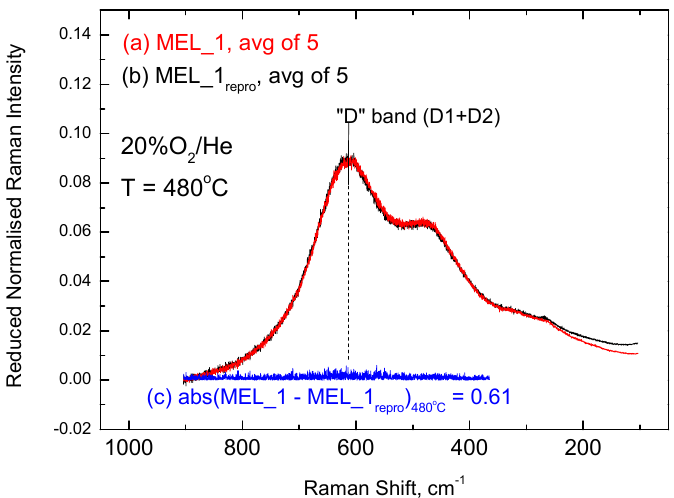
Figure 3. Reduced and normalized in situ Raman spectra obtained for two specimens of the same lot of the MEL_1 material under 20% O 2 /He at 480 °C. ( a ) Average of five sequential recordings for MEL_1; ( b ) average of five sequential recordings for MEL_1 repro ; ( c ) absolute difference of traces (a) and (b). The 0.61 value corresponds to the integral under trace (c). Recording parameters, see Figure 1 caption.